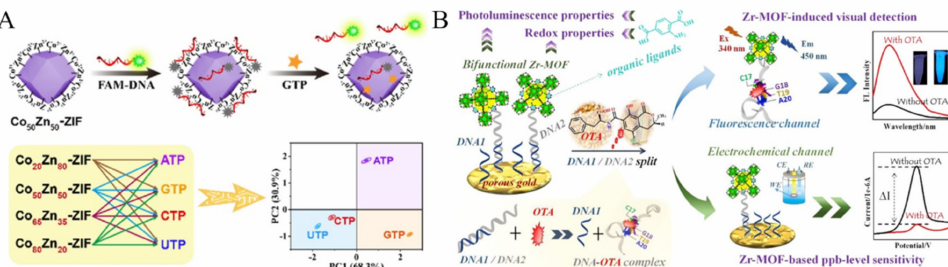
Figure 11. ( A ) Schematic illustration of DNA coated CoZn-ZIF MOFs for fluorescent sensing GTP. Reproduced with permission [165]. Copyright 2022, Elsevier. ( B ) Schematic illustration of the dual- channel Zr-MOFs-based detection strategy of OTA. Reproduced with permission [169]. Copyright 2022, American Chemical